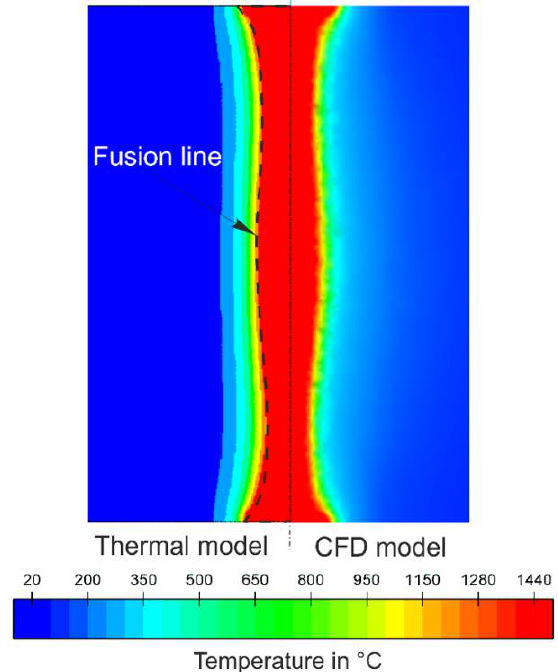
Figure 12. Comparison of the temperature fields of the CFD and the thermal model.